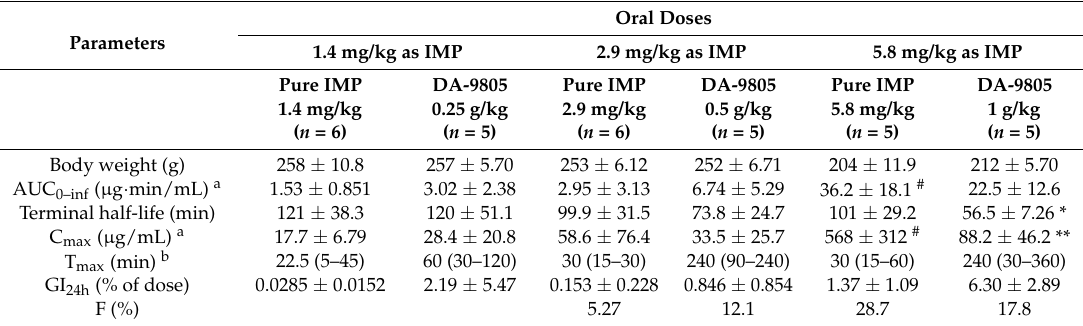
Table 4. Pharmacokinetic parameters of IMP after oral administration of pure IMP or DA-9805 at doses equivalent to 1.4, 2.9, and 5.8 mg/kg of DA-9805 to rats (mean ± SD).